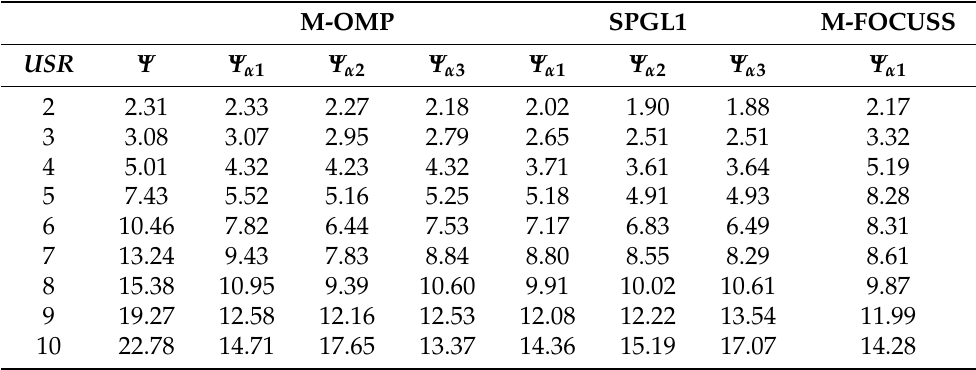
Table 4. Comparison of PRD values from the algorithms using the three dictionary matrices at several USR values, for the ECG signal No.